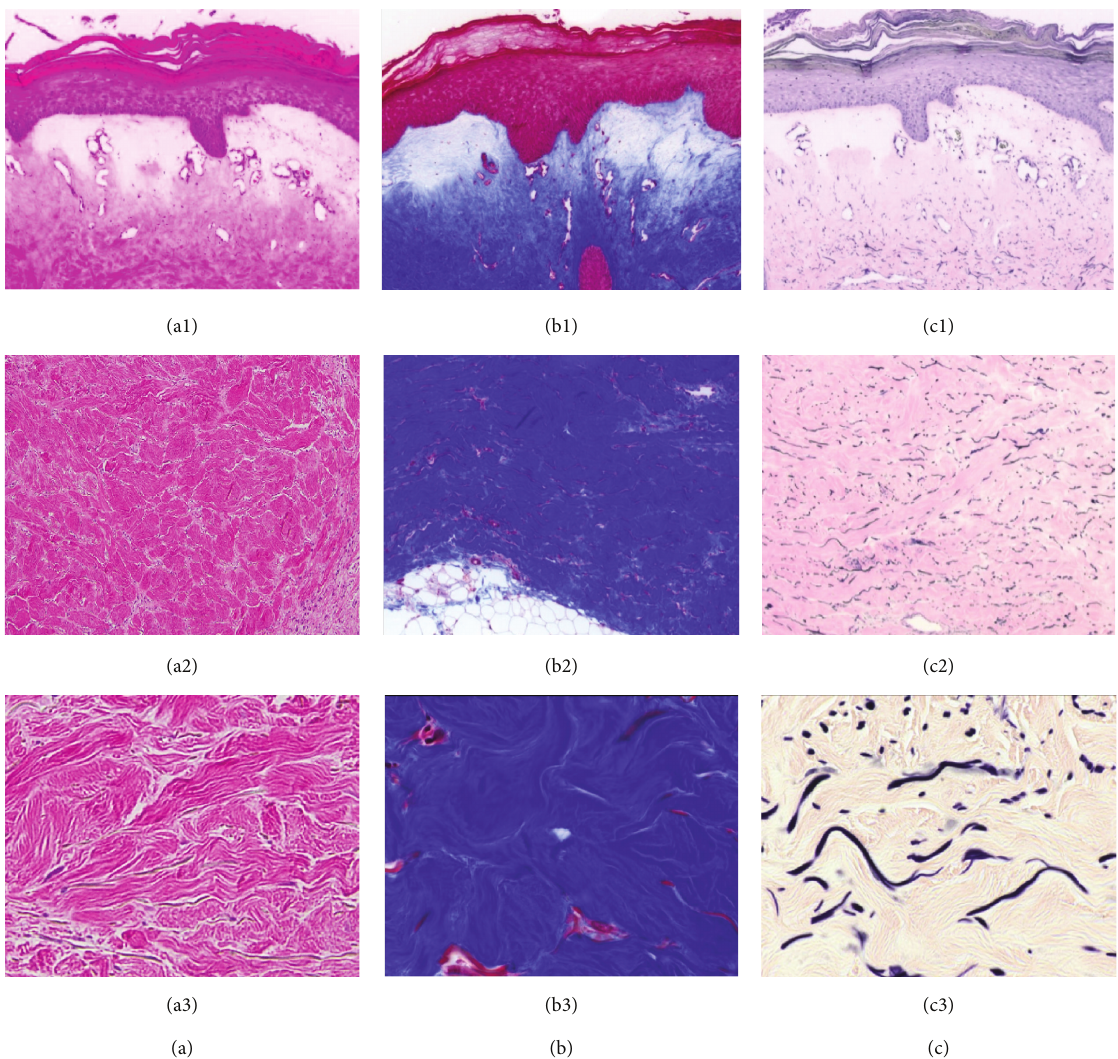
Figure 2: Histochemistry of lesional skin from patient with LEMD3 Trp620X mutation. (a) H&E stain. (b) Masson’s trichrome staining. (c) Elastin staining. (a1), (b1), and (c1) represent 100x magnification of the epidermis, (a2), (b2), and (c2) represent 100x magnification of the dermis, and (a3), (b3), and (c3) show 630x magnification of the dermis. Note increase in both collagen and elastin deposition and irregular collagen